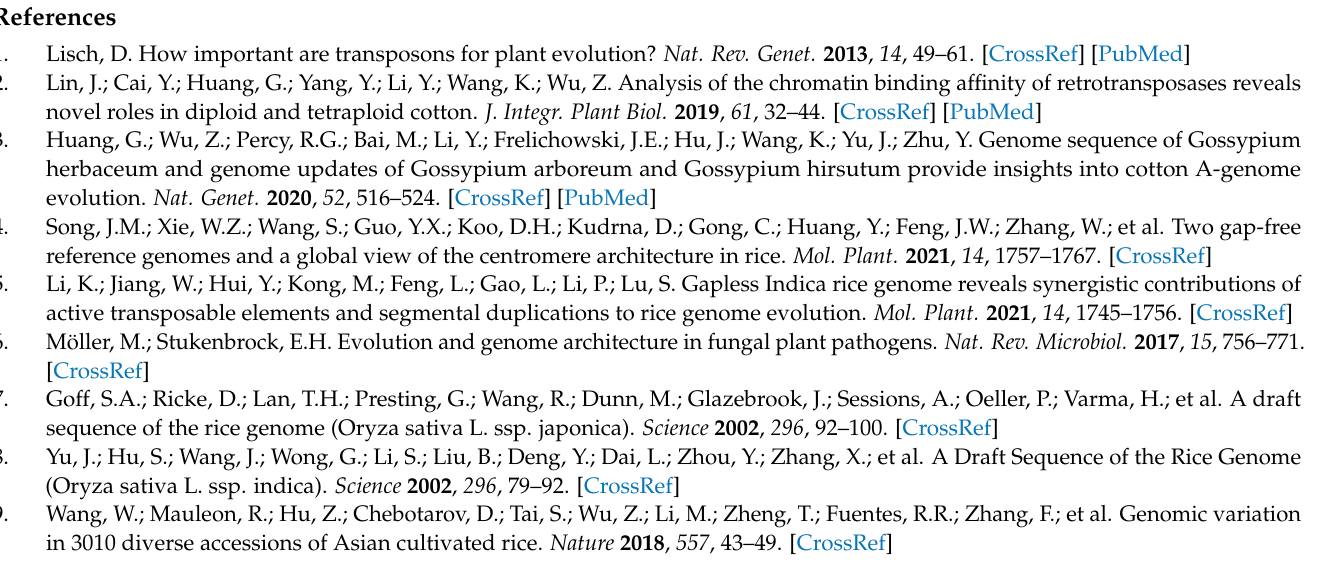
Table S2: The centromere locations and length statistics for different chromosomes in the Nip